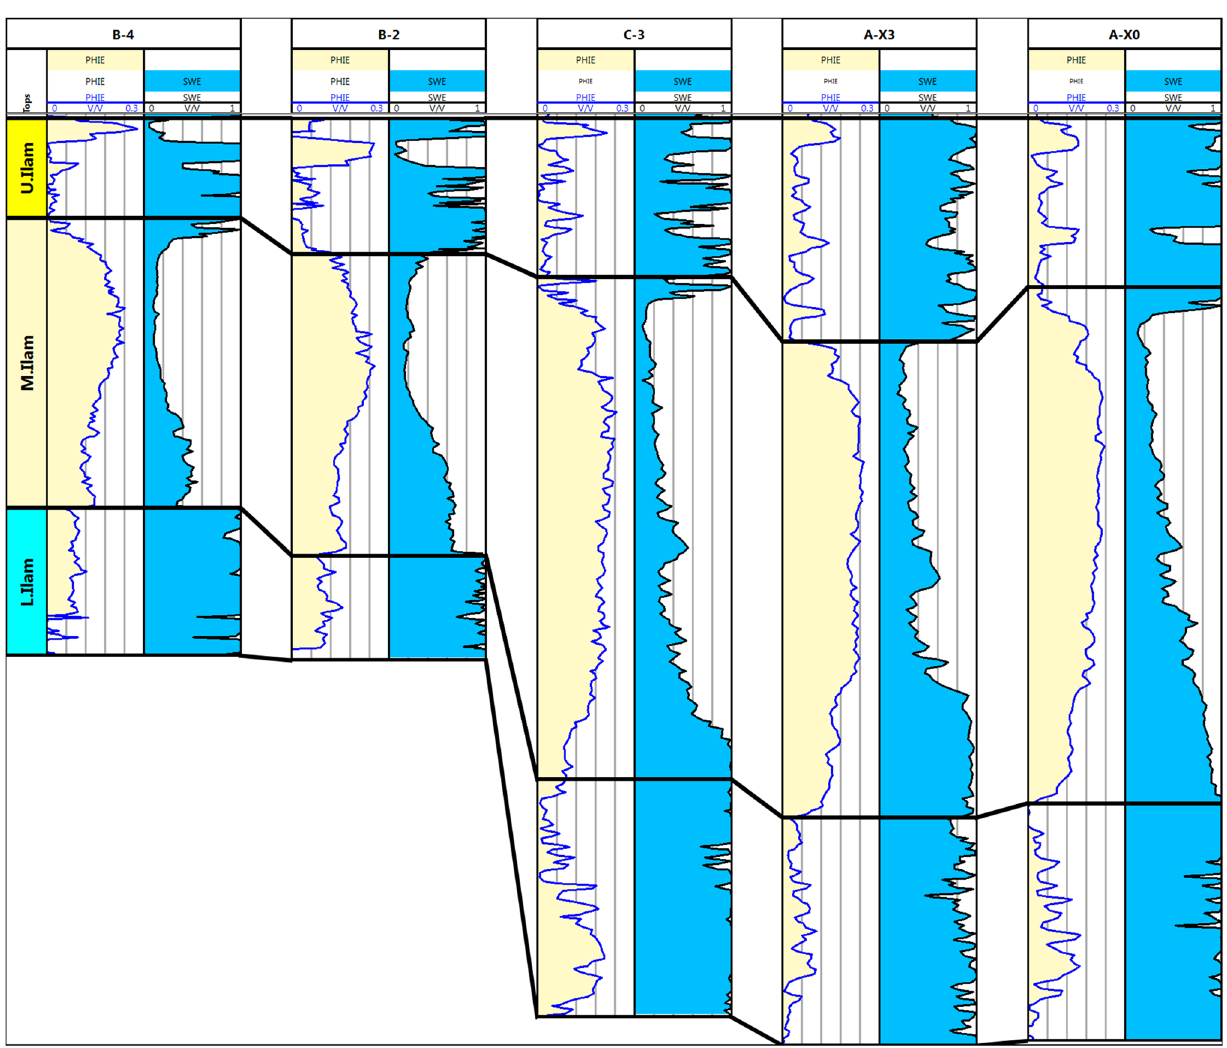
Fig. 5 Correlation of key wells in three fields under study. Although the thickness of Main Ilam as the main reservoir changes through these fields, the reservoir properties do not bear a rapid change so as to act as a lateral